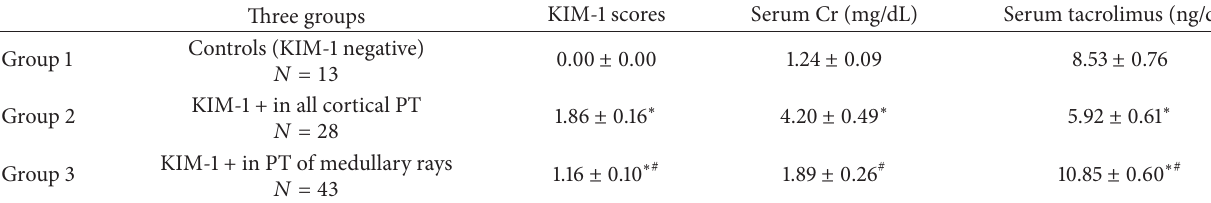
Table 2: KIM-1 score, renal functional indices, and tacrolimus levels in three groups of renal transplant biopsies.